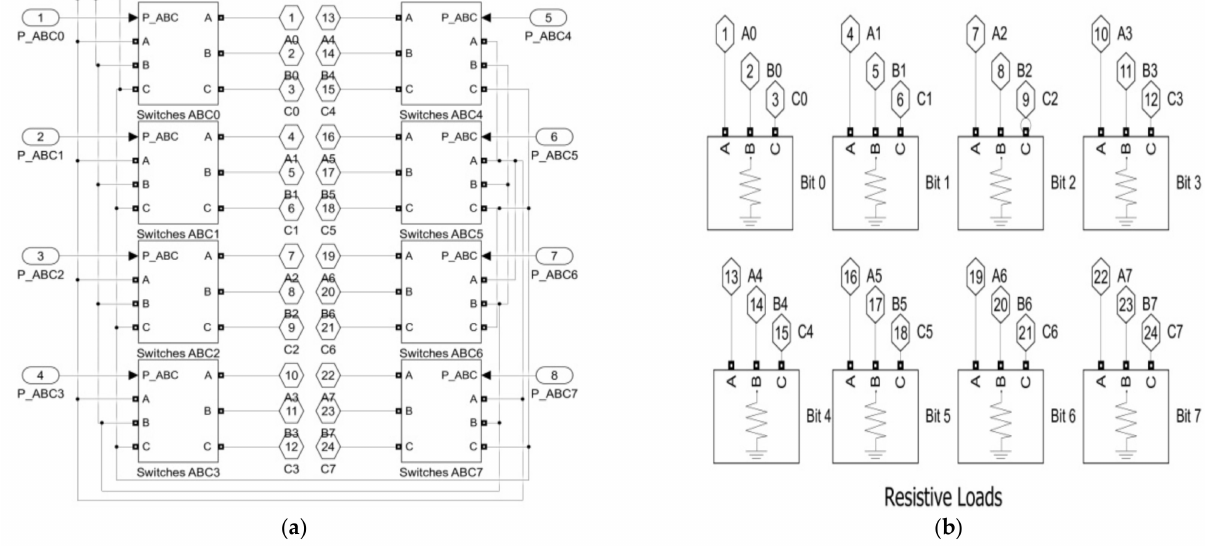
Figure 2. ( a ) Eight-bit three-phase GTO switches. ( b ) Operational block diagram of three-phase resistive